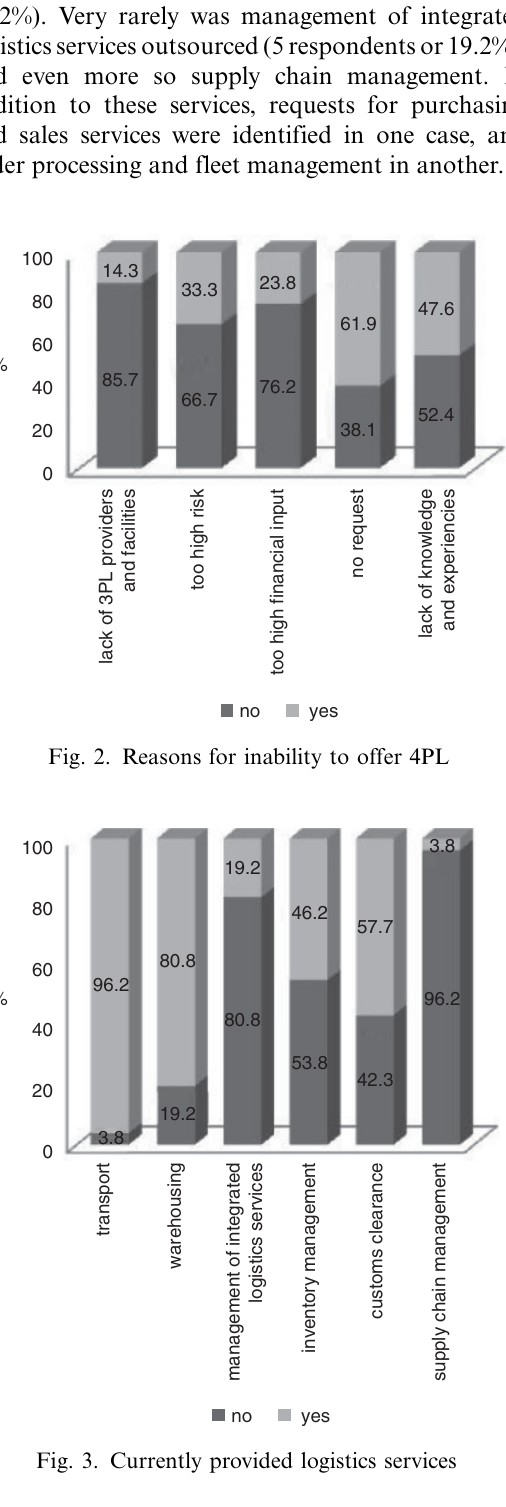
Fig. 3. Currently provided logistics services